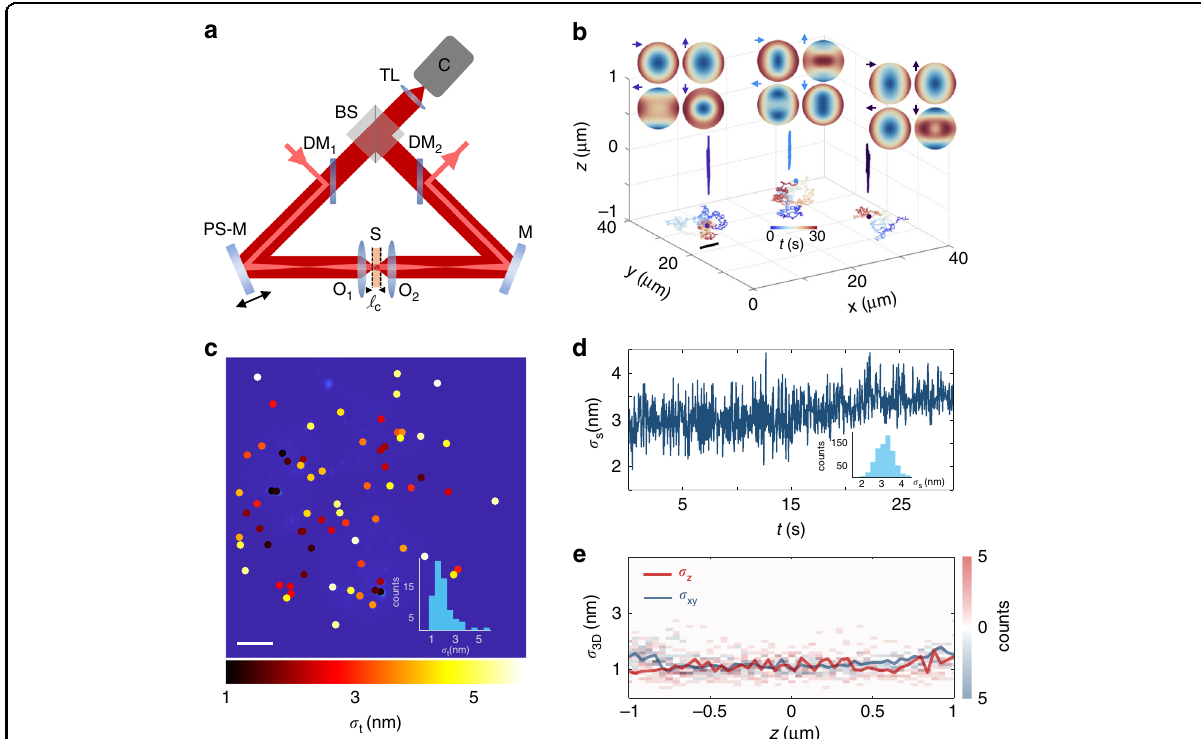
Fig. 1 Method and characterization of TEMPSI. a In the TEMPSI system, the excitation beam (light red) is directed to the sample (S) via a dichroic mirror (DM 1 ), the phase-shifting mirror (PS-M), and the objective lens (O 1 ) to provide wide fi eld illumination. The beam exists the system through the fi xed mirror (M) and another dichroic mirror (DM π -steradian fl uorescence emitted around the zero optical path length difference point of the 2 ). The 4 4 π -cavity (to within ± ‘ c = 2) is collected by the two opposing objectives lenses (O 1/2 ) and the fl uorescence self-interference at the beam splitter (BS) is imaged onto the camera (C) using a tube lens (TL). The phase-shifting mirror temporally changes the optical path length difference in the 4 π -cavity, producing multiple interferograms from which the unambiguous nanometer localization of the fl uorescent emitters is obtained in space. b 3D-SPT using TEMPSI is accomplished by acquiring four interferograms per 3D localization, with π /2 phase shift between consecutive frames (top insets where arrows signify the temporal phase shift introduced, explicitly 0, π /2, π , 3 π /2). The continuous acquisition of the phase shift interferograms allows to 3D localize the particles across the fi eld of view. The localizations are subsequently used to reconstruct the particle trajectories in space (shown in different colors with zoomed color-encoded time-elapsed insets). c Image of immobile fl uorescent beads with the temporal standard deviation of their axial localizations σ t in colored dots. The histogram of σ t is also shown. Phase shift interferograms were acquired over 30 s at 100 Hz, resulting in 25 3D localizations s − 1 with an average of ~60 × 10 3 photons/localization. Scale bar, 5 μ m. d Spatial standard deviation of the axial localizations σ s as a function of time. The histogram of σ s is also presented. σ s was evaluated from the same data in ( c ). e TEMPSI localization precision in the lateral and the axial directions, σ xy and σ z , over an axial range of 2 μ m. The localization precision was evaluated using 10 immobile fl uorescent beads scanned over an axial range of 2 μ m. For each bead, we measured 50 localizations/axial-position at 25 Hz and with an average of ~130 × 10 3 photons/localization. Color-coded histograms of the precision at each axial position are shown ( σ xy , blue shades; σ z , red shades) along with the medians (solid lines with corresponding